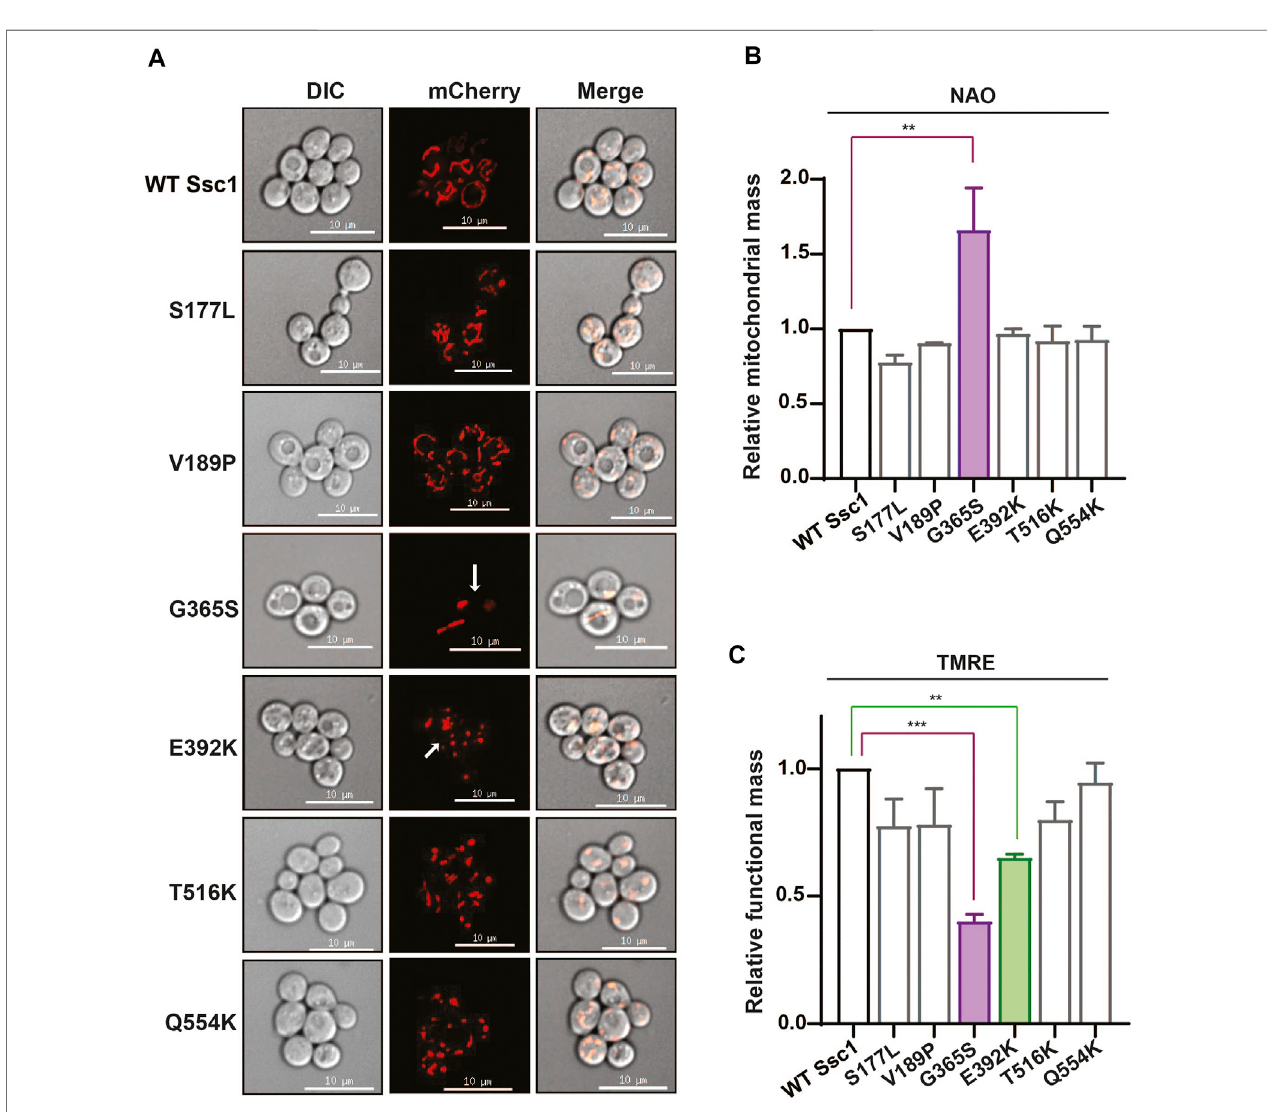
FIGURE3| CSAmutationsperturbmitochondrialphysiology. (A) Mitochondrialmorphology.Wild-typeandmutantcellsweretransformedwithRFPfusionprotein, MTS-mCherry to visualize the mitochondrial network. Images were captured at identical exposures and analyzed using SoftWoRx 6.1.3 software. Scale 10 µm. (B,C) Quanti fi cation of total and functional mitochondrial mass. Equivalent cells grown up to mid log phase were stained with (B) 10 µm NAO and (C) 8.75 µM TRME to quantify the total and functional mitochondrial mass respectively. Fluorescence median intensities of 10,000 cells were obtained, normalized with respect to the wild-type represented as Mean ± S.D of three independent